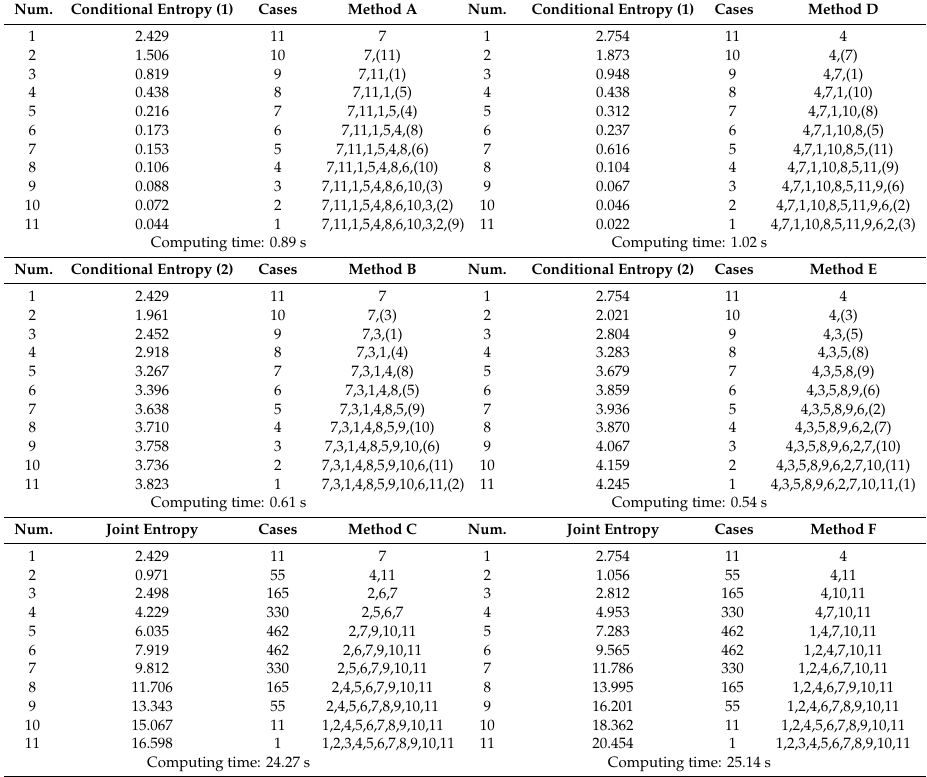
Table A3. Results of a select optimal rain gauge network of methods